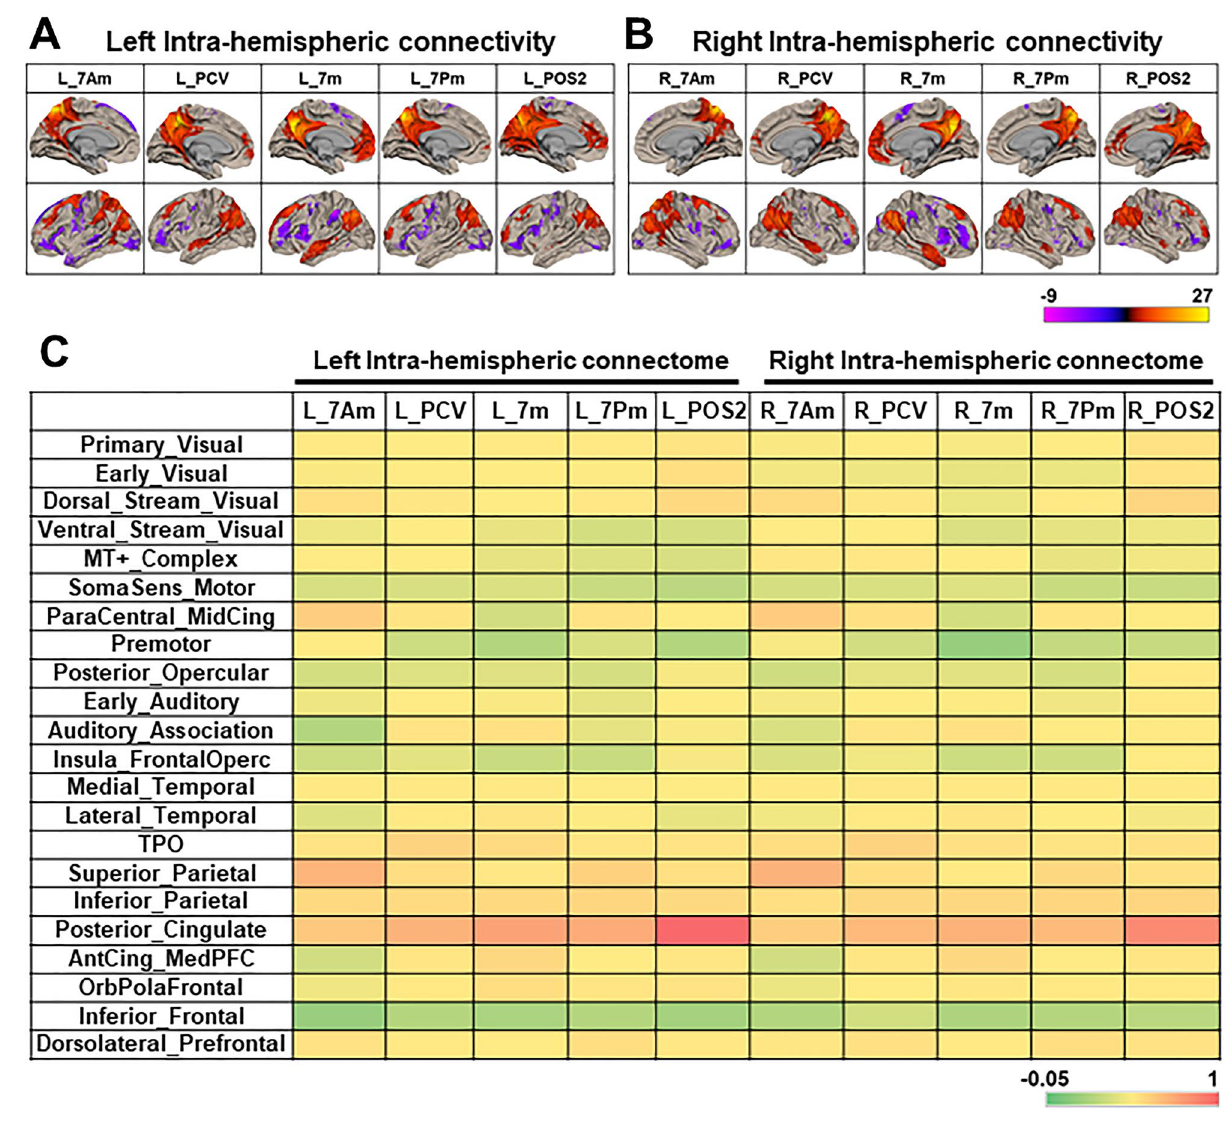
Figure 3. Intra-hemispheric functional connectivity (FC) of precuneus. ( A , B ) Seed-based RSFC of each precuneus ROI (7Am, PCV, 7Pm, 7m, POS2) in the left ( A ) and right ( B ) hemisphere, respectively. The regions with significant neural correlate at second-level analysis (voxel-level p < 0.001 uncorrected, cluster-level p < 0.05 FDR corrected) were rendered on the template brain (white matter surface). The color bar represents T-values, in which warmer colors indicate higher T-values. ( C ) Color map showing the intra-hemispheric group-average connection matrix of FC strength (group-average pairwise ROI correlation) between each precuneus ROI (7Am, PCV, 7Pm, 7m, POS2) and the 22 Cortical Divisions of the HCP MMP atlas. The color scale bar indicates the group-average correlation coefficient (− 0.05 < r < 1). The rows show the 22 Cortical Divisions of the HCP MMP atlas, while the lines show the 5 seed regions of the precuneus in the left (L) and right (R) hemisphere, respectively. The details of 22 Cortical_Divisions in HCP MMP atlas are shown in Supplementary Fig.